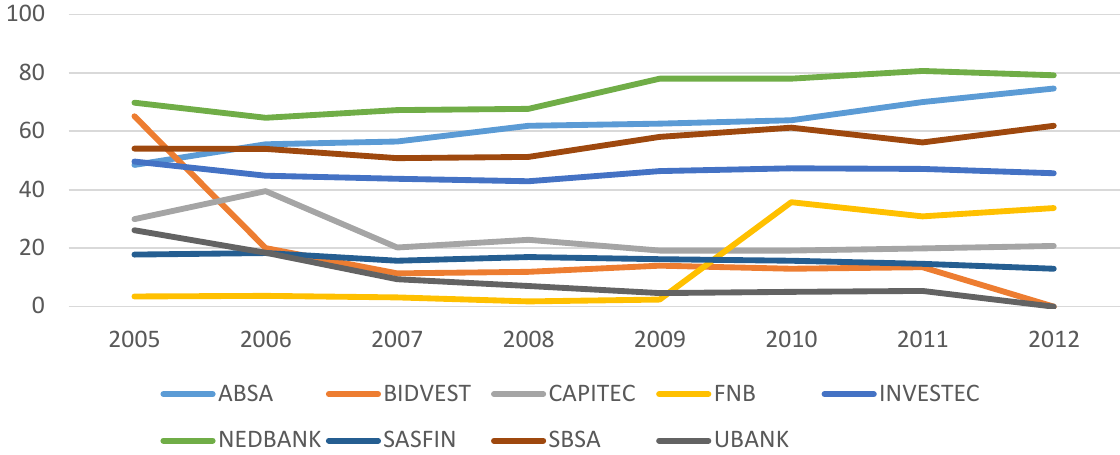
Figure 2. Dependent variable –